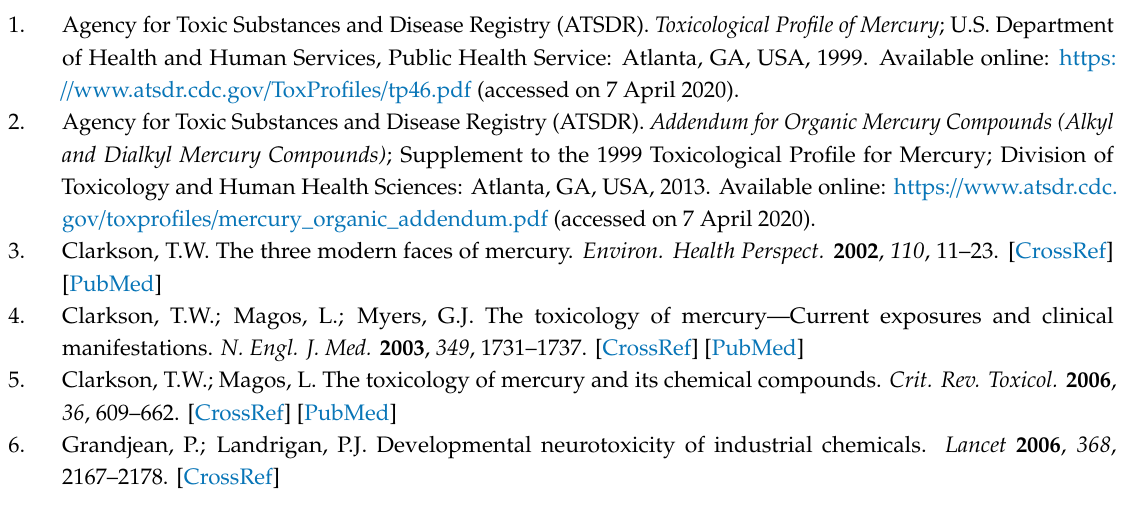
Table S1: Temperature program of microwave digestion system UltraCLAVE IV (Milestone, Sorisole, Italy), Table S2: ICP-MS Agilent 7500cx (Agilent Technologies, Tokyo, Japan) optimized working conditions, Table S3: Comparison between the reference values and the obtained values of Hg and Se in the reference materials